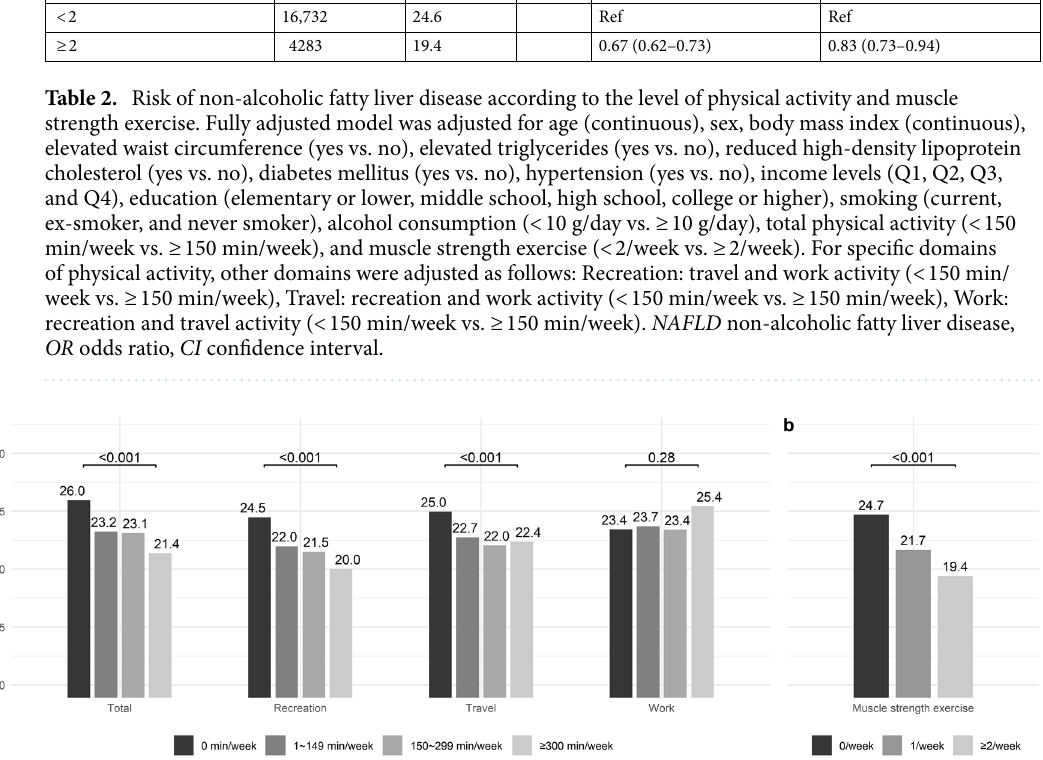
Figure 2. Prevalence of non-alcoholic fatty liver disease according to the level of ( A ) physical activity (total, recreation, travel, work) and ( B ) muscle strength